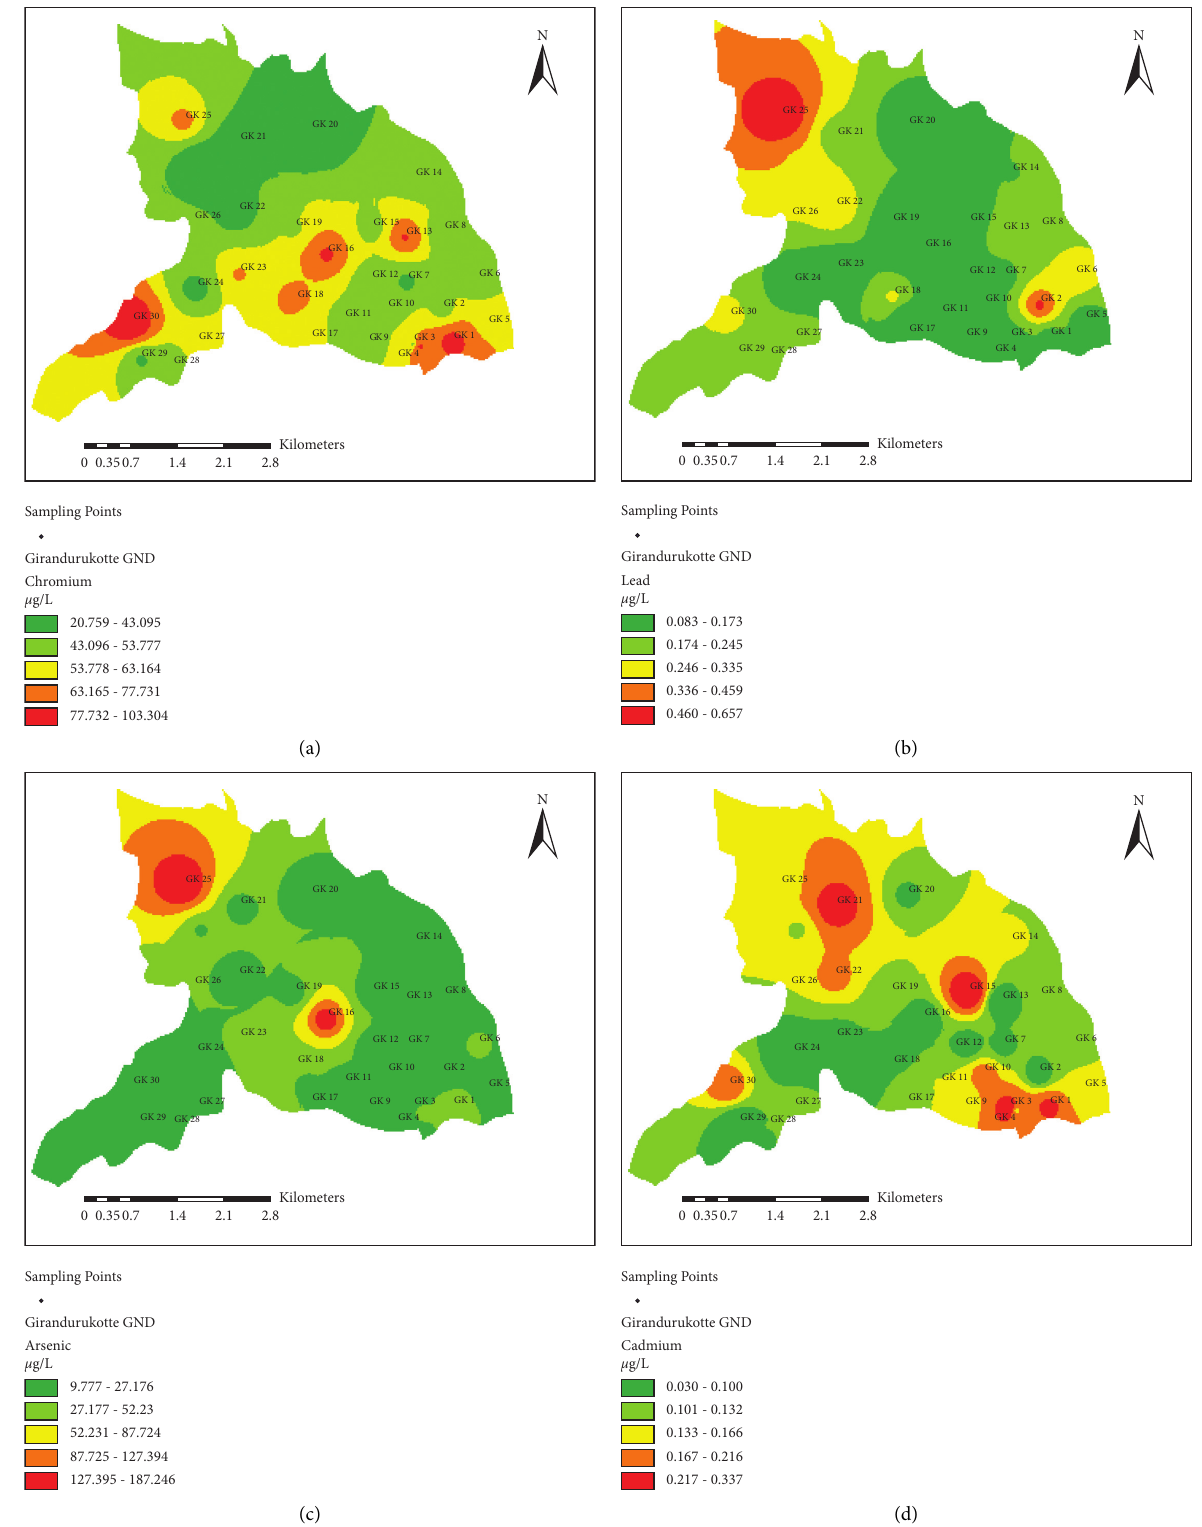
Figure 3: The geospatial distribution of (a) Cr, (b) Pb, (c) As, and (d) Cd in the collected drinking water samples from Girandurukotte GND, Badulla district, Sri